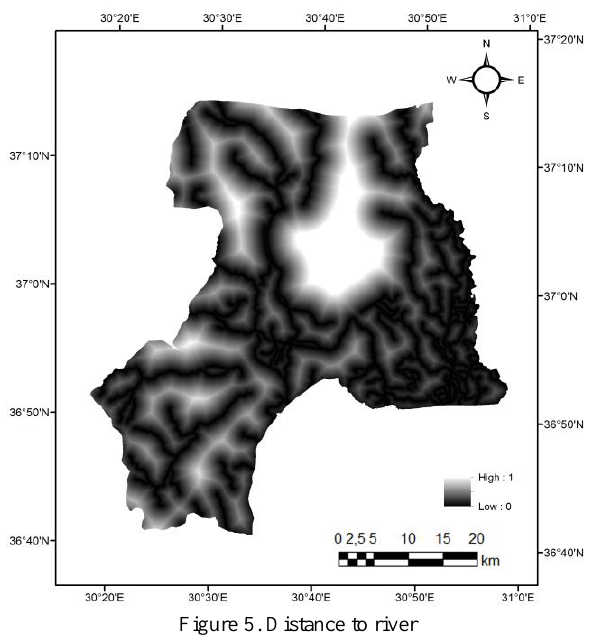
Figure 5. Distance to river